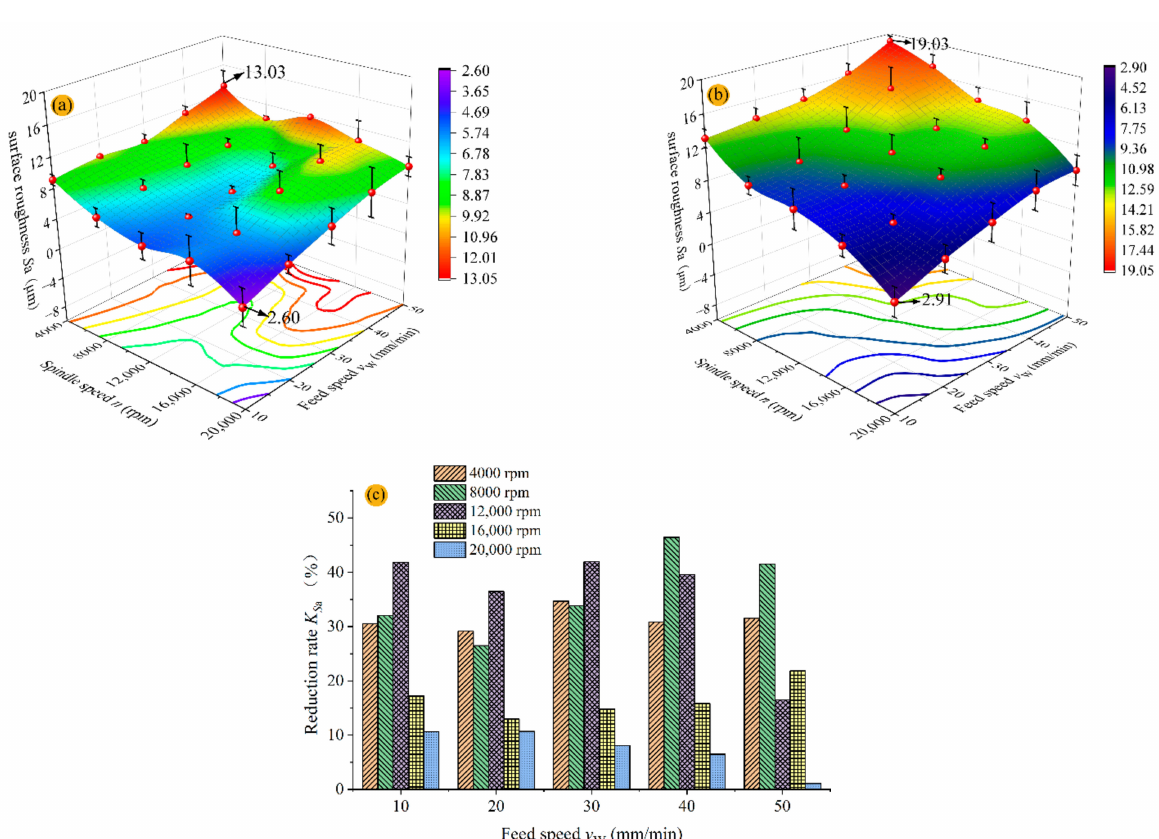
Figure 12. Surface roughness and reduction rate effects of drilling parameters, ( a ) surface roughness variation trend in RUAD, ( b ) surface roughness variation trend in CD, and ( c ) reduction